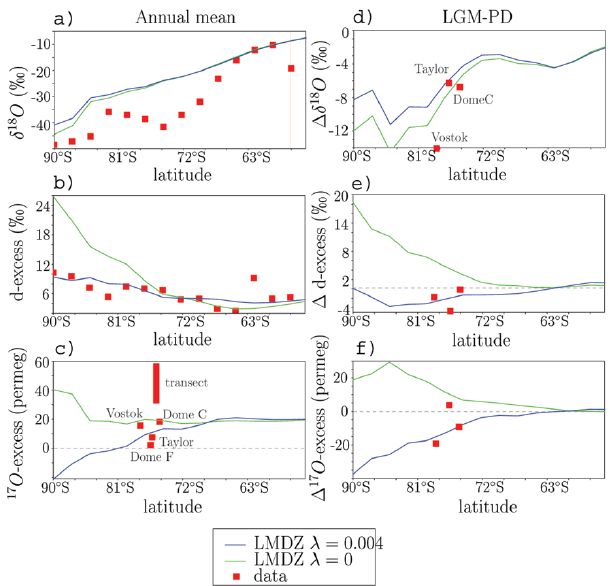
Fig. 11. (a–c) Zonal, annual mean δ 18 O, d-excess and 17 O-excess in precipitation in Antarctica simulated by LMDZ for the control value of λ (blue) and when λ is set to 0 (green). Model outputs are collocated with observations. (d–f) Same for zonal, annual mean LGM-PD difference. In all plots, model outputs are compared qual- itatively (i.e. with no collocation) with observations (black squares). For δ 18 O and d-excess, values are zonal averages from the GNIP- Antarctica data set regridded on LMDZ grid. For 17 O-excess, nu- merical values are those given in Tables 2 and